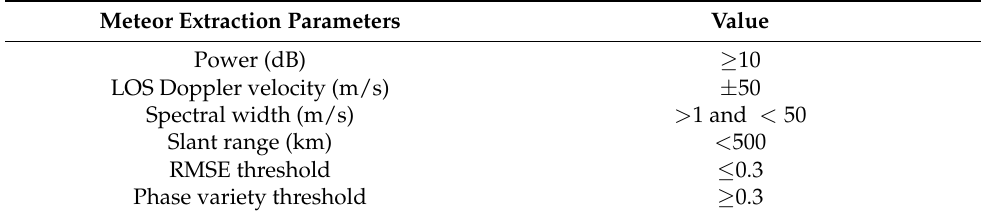
Table 4. Improved meteor echo recognition